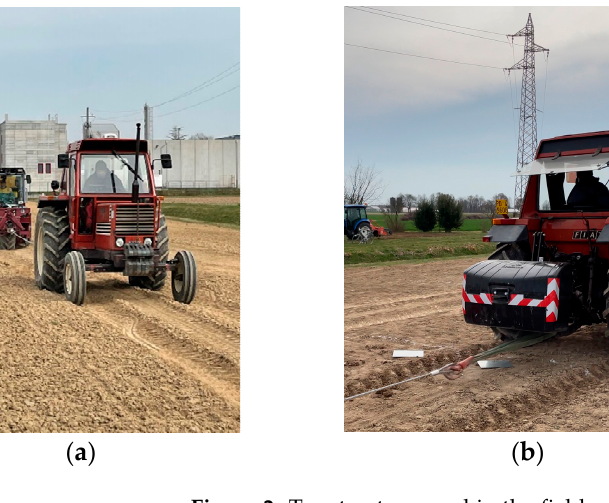
Table 1. Technical data of the tractors used in the experiment.